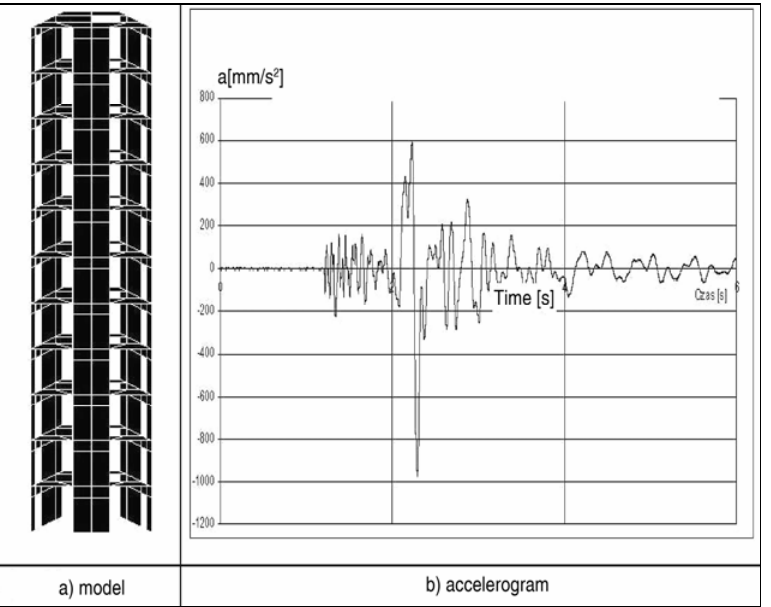
Fig 13 . Computational model of the single staircase and its foundation acceleration